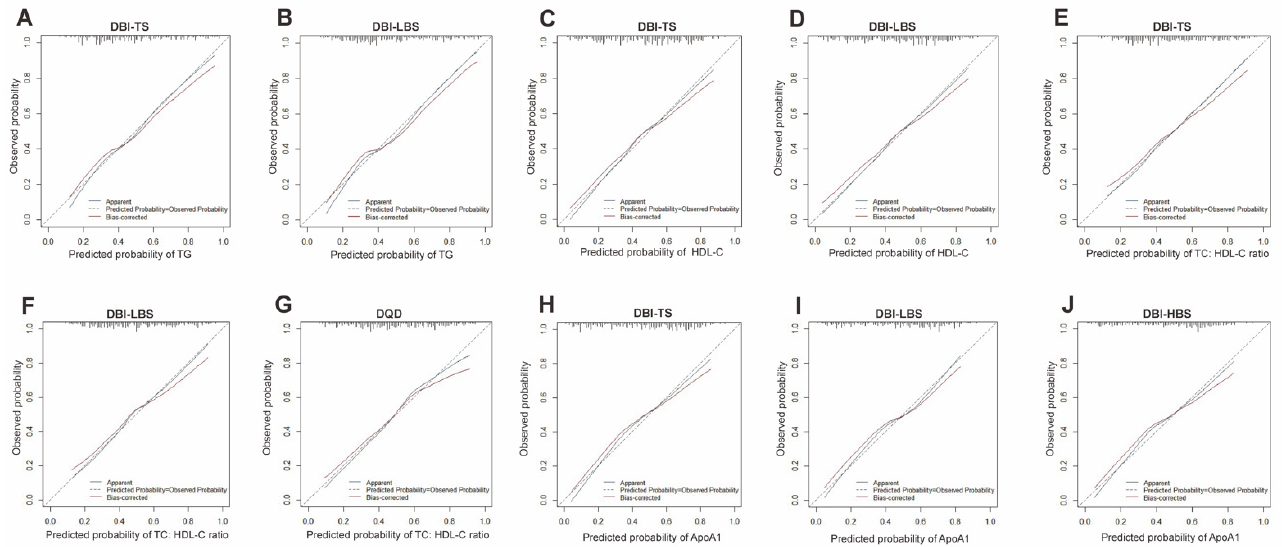
Figure 2. Calibration curve of the logistic regression models. For model validation, internal validation was adopted using a bootstrapping method with 1000 bootstrap resamples of 269 participants for Bias-corrected calibration curves. The apparent calibration curves were performed with the dataset of 269 participants. The predicted probabilities of TG (( A ): DBI-TS, ( B ): DBI-LBS), HDL-C (( C ): DBI-TS, ( D ): DBI-LBS), TC: HDL-C (( E ): DBI-TS, ( F ): DBI-LBS, ( G ): DQD) and ApoA1(( H ): DBI-TS, ( I ): DBI-LBS, ( J ): DBI-HBS) by the logistic regression model conforms well to the observed probability. In the plot, all apparent calibration curves and Bias-corrected calibration curves are consistent with and the ideal lines (Predicated Probability = Observed Probability).